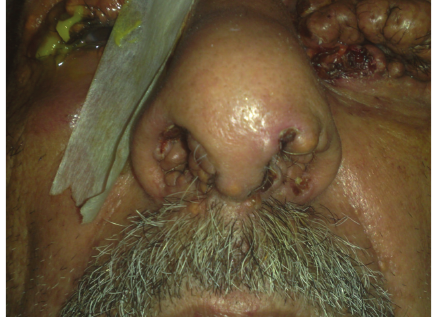
Figure 1: Tumor-like lesions on periorbital area, the ulceration like lesion do to biopsy’s site.